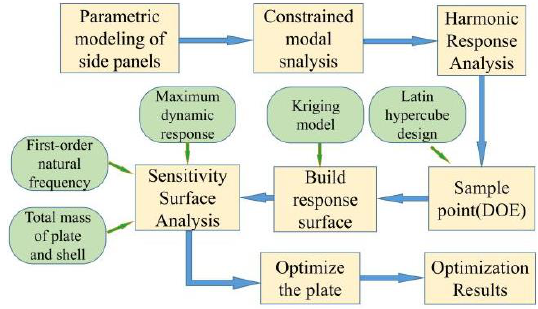
Figure 15. Optimization steps of Workbench.